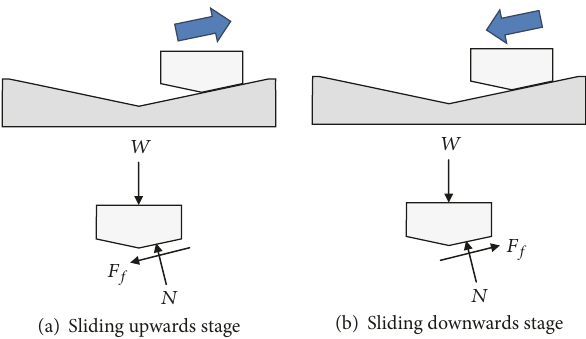
Figure 3: Action force between double beveled substrate and sliders in the process of movement.